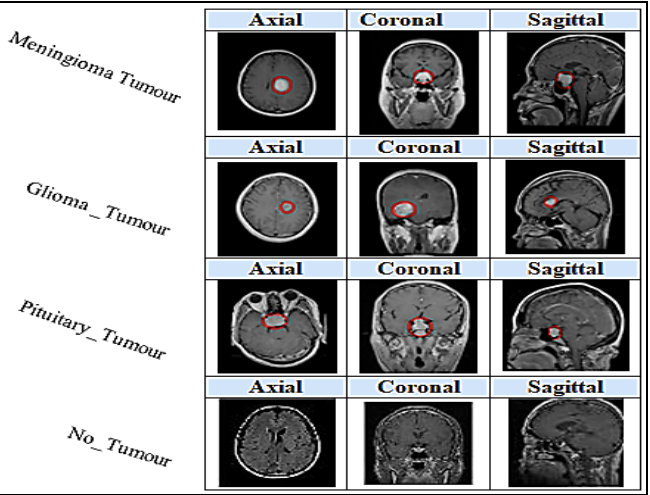
Figure 7. The brain tumour types in three planes.